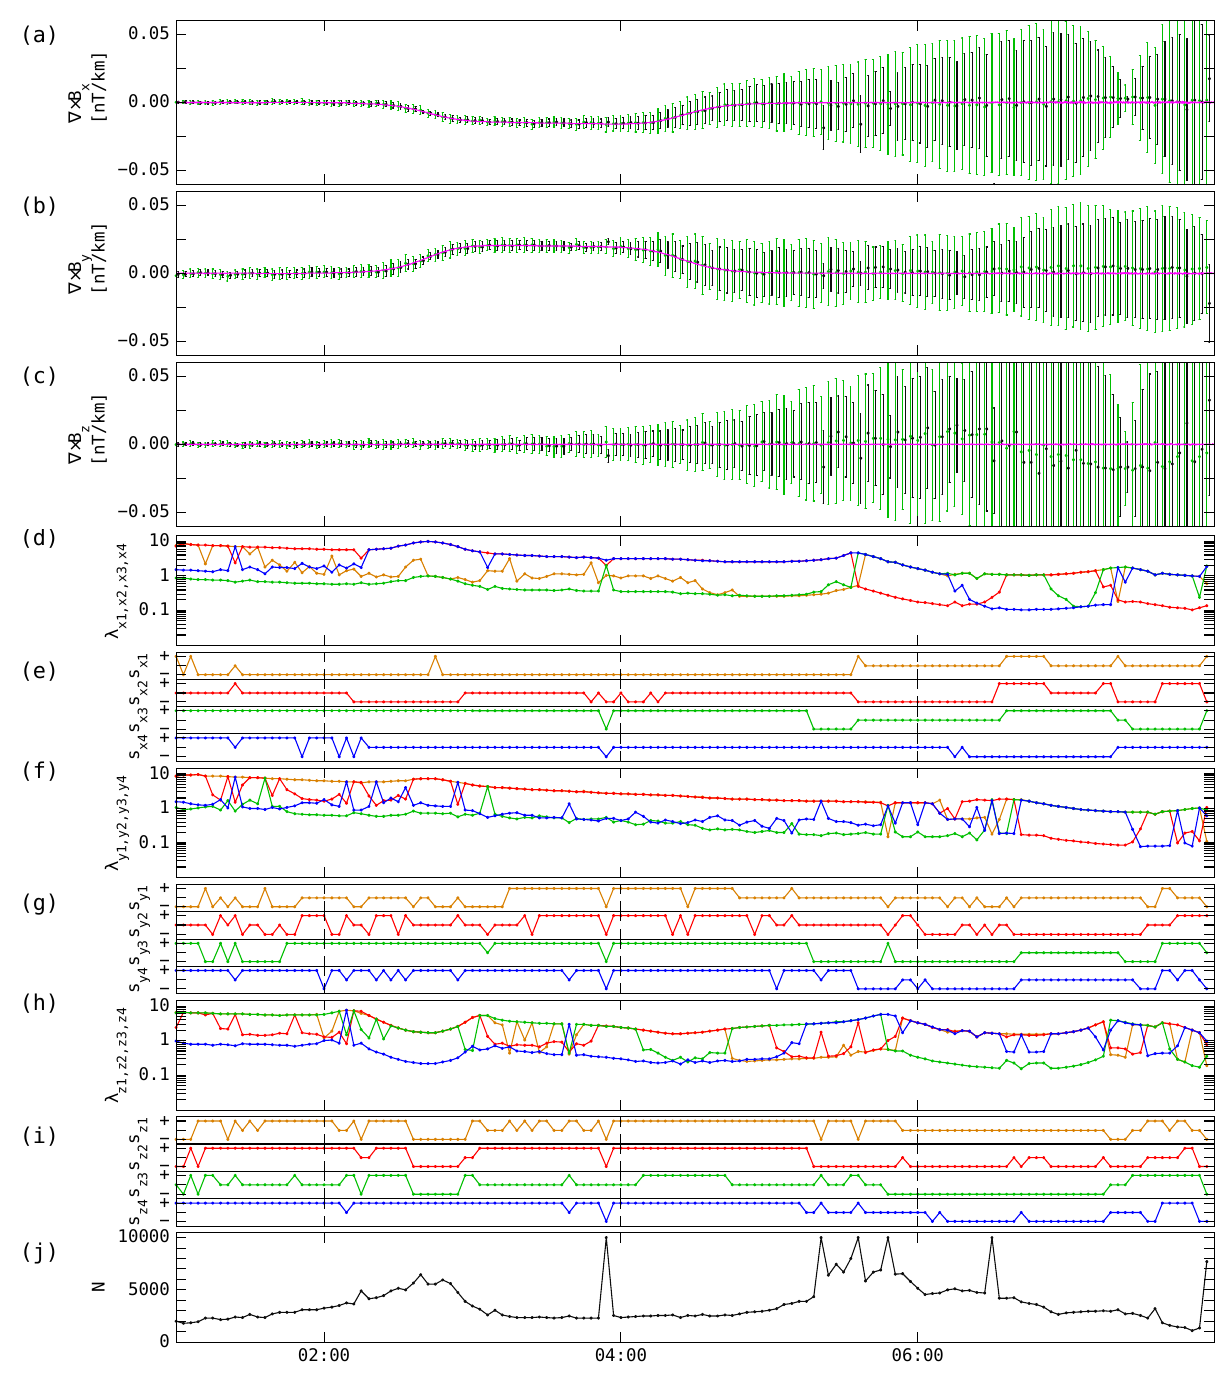
Fig. 13. Curl of the magnetic field, ∇ × B , obtained from least-squares gradient computation for the field components, subject to the condition ∇ · B = 0, in the dipole with ring current illustrated in Figs. 11 and 12 for a 4-spacecraft configuration. The data were smoothed at a 60s time scale and resampled at 30s resolution. (a–c) LSGC calculation of the x-, y-, and z-components of ∇ × B with common rescaling (green) and direction-dependent rescaling (black), compared to the exact solution (magenta). (d) and (e) Relative homogeneity lengths and curvature signs for direction-dependent rescaling for ∇ B x ( λ 1 orange, λ 2 red, λ 3 green, λ 4 blue). (f) and (g) Idem for ∇ B y . (h) and (i) Idem for ∇ B z . (j) Number of equations in the coupled overdetermined system for the three gradients.